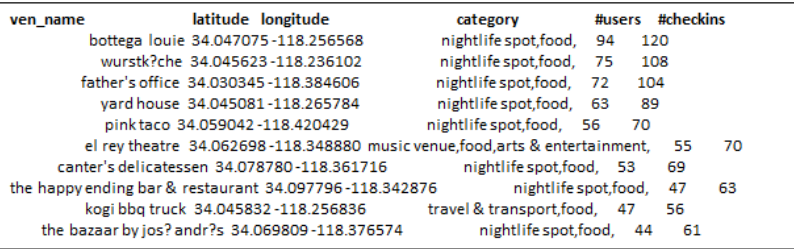
Figure 11. Top-10 influential locations in Log Angles using t-GIR